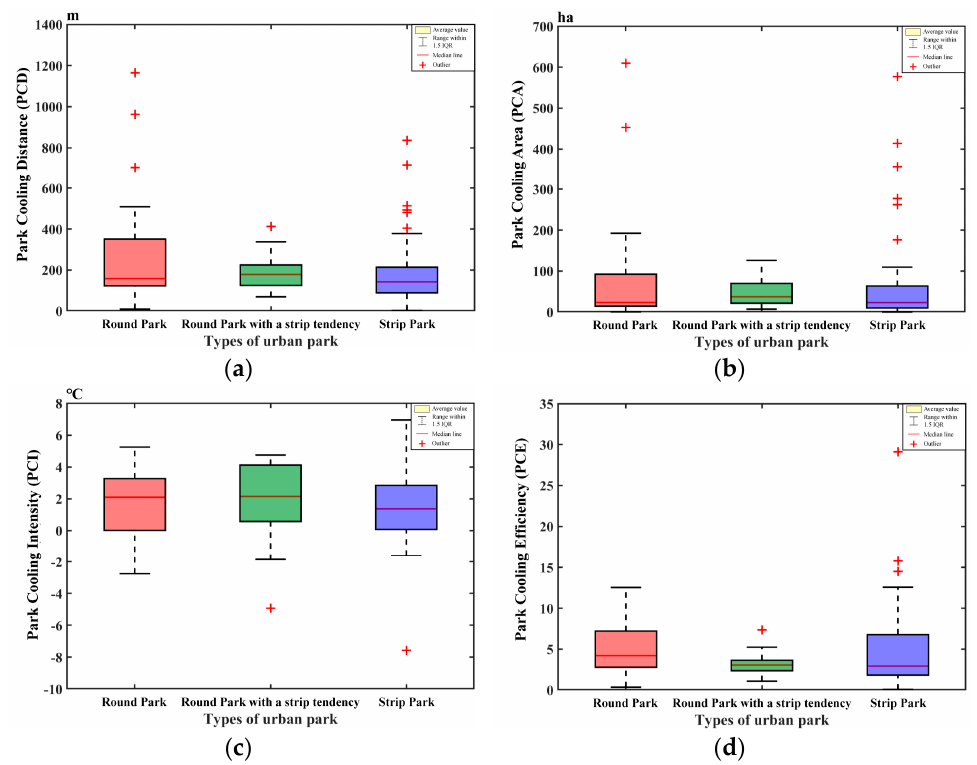
Figure 5. Cooling indexes of the 67 urban parks: ( a ) park cooling distance; ( b ) park cooling area; ( c ) park cooling intensity; ( d ) park cooling efficiency.